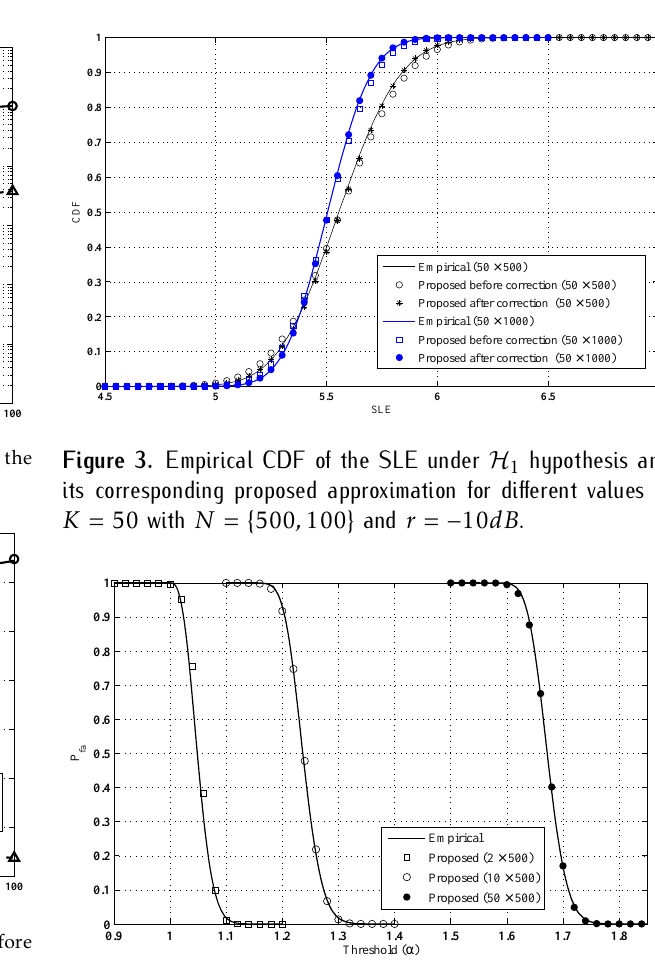
Figure 4. Empirical probability of false alarm for the SLE ) and detector and its corresponding proposed form in (29) for different SLE values of K with N = 500